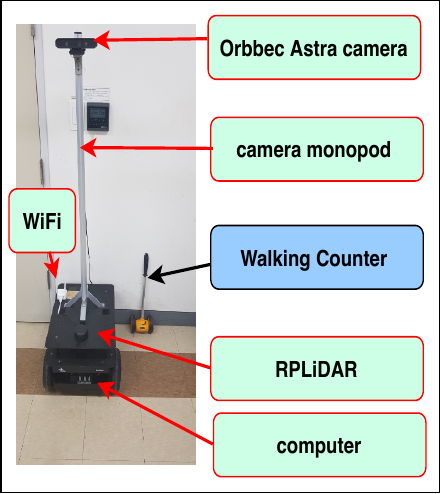
Figure 6. Mobile robot equipped with an RGB-D camera and range finding sensor.